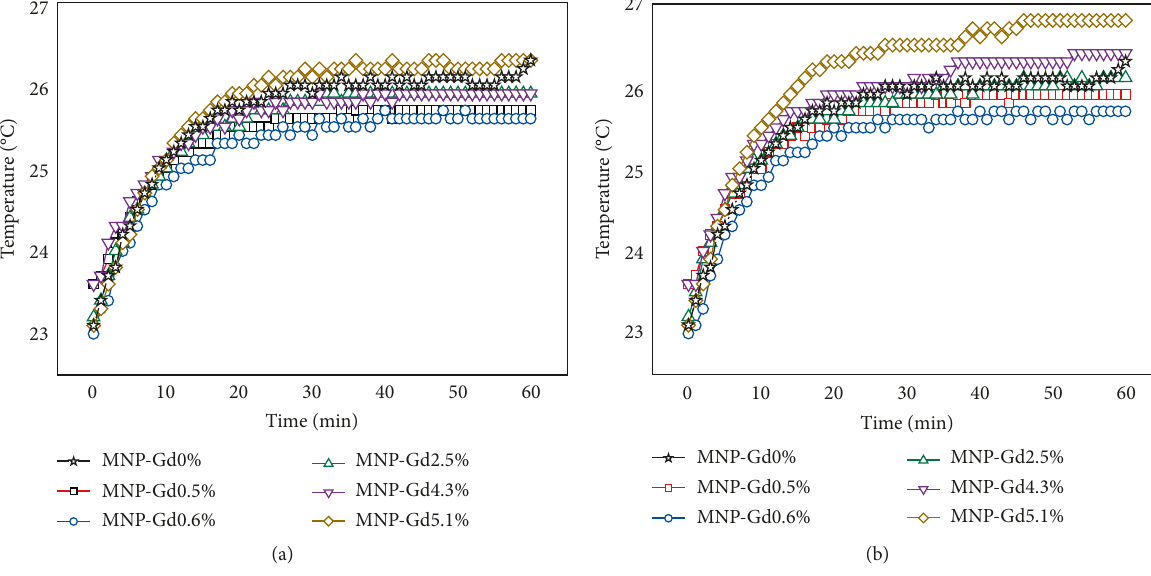
Figure 5: In the legends of figures 5a and 5b, please change (1), (2), (3), (4), (5), and (6) to MNP-Gd0%, MNP-Gd0.5%, MNP-Gd0.6%, MNP-Gd2.5%, MNP-Gd4.3%, and MNP-Gd5.1%,